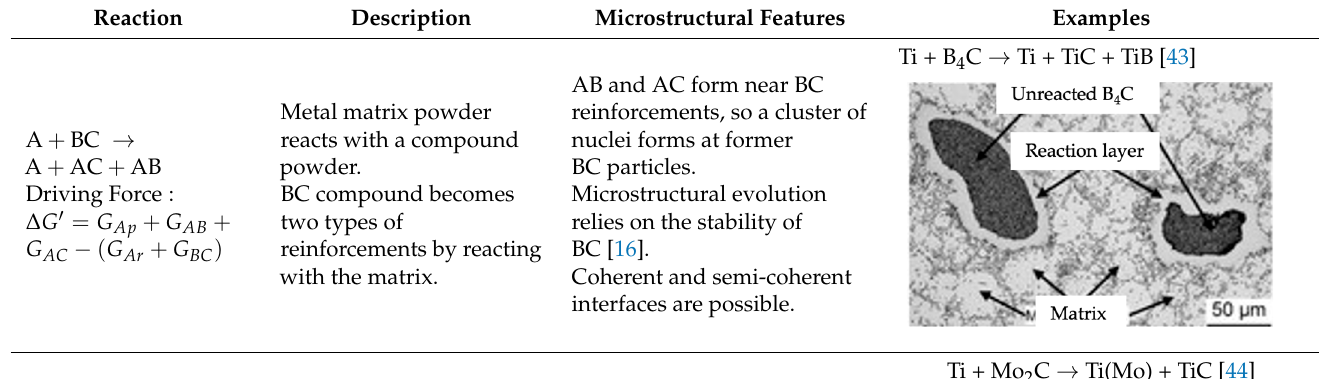
Table 1. Raw material possibilities for composites of type A + AB. Δ G is the Gibbs free energy change of the reaction, G is the Gibbs free energy of element i, and p B is the partial pressure of B in atm. R and P subscripts in the fourth column stand for reactant and product amounts of A, respectively. For the sake of simplicity, there is no mass balance in the reaction equations. Figures in the “exam- ples” column are meant to illustrate microstructural features listed in the summary. Reaction